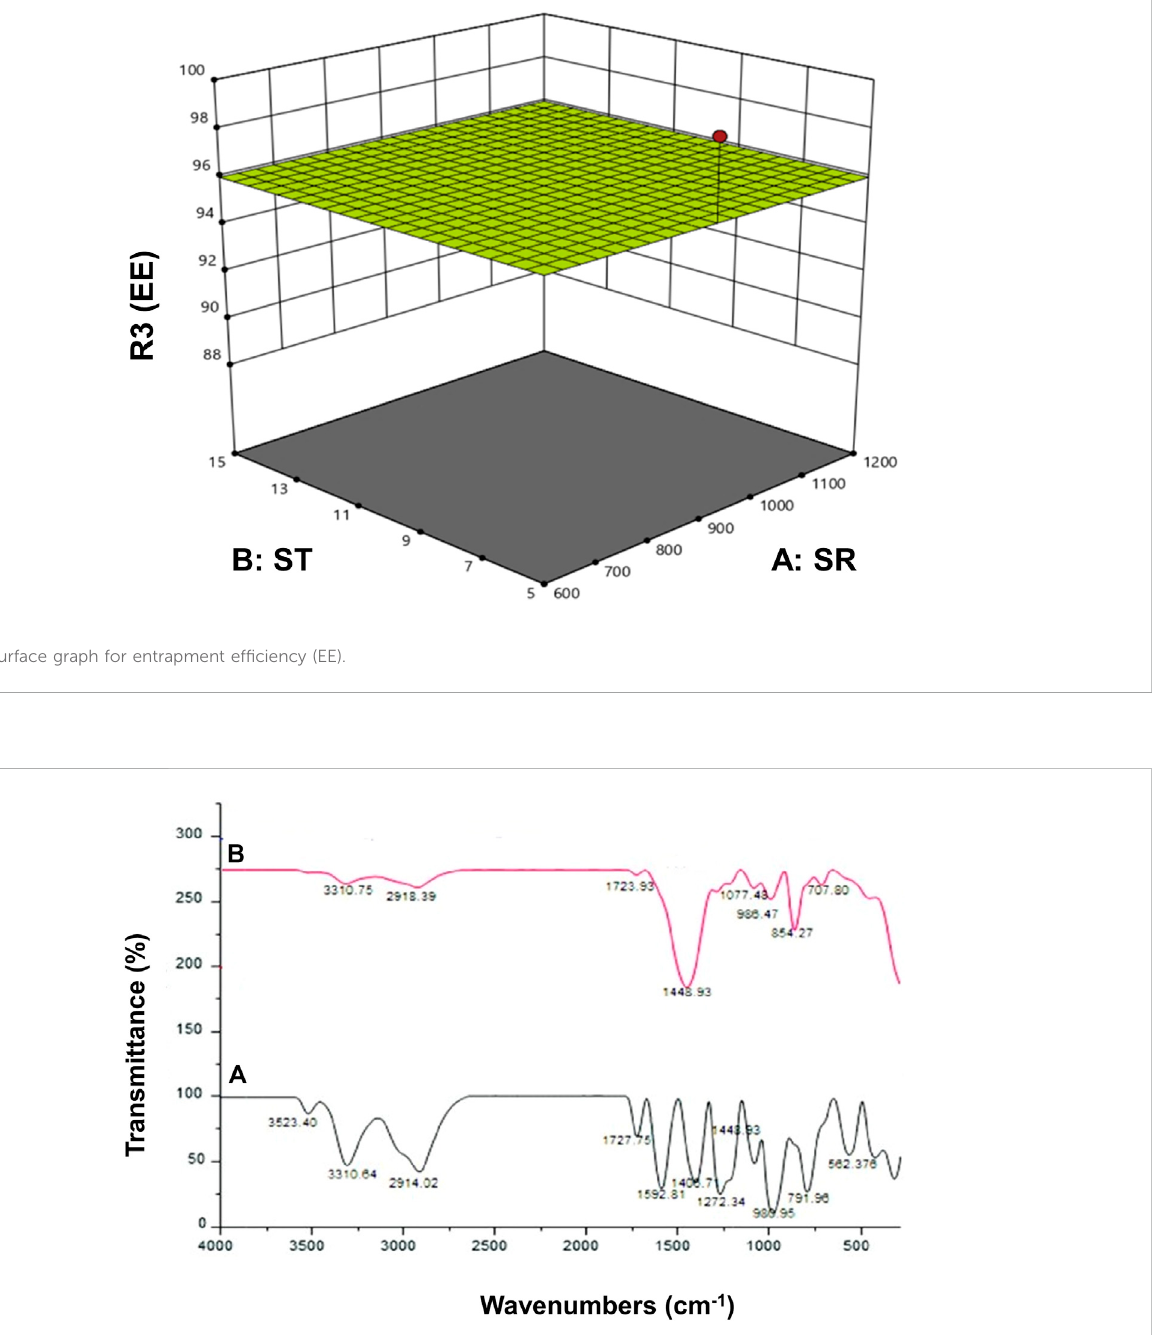
Fourier transform infrared (FT-IR) spectra of (A) DOX (Pure) (B)